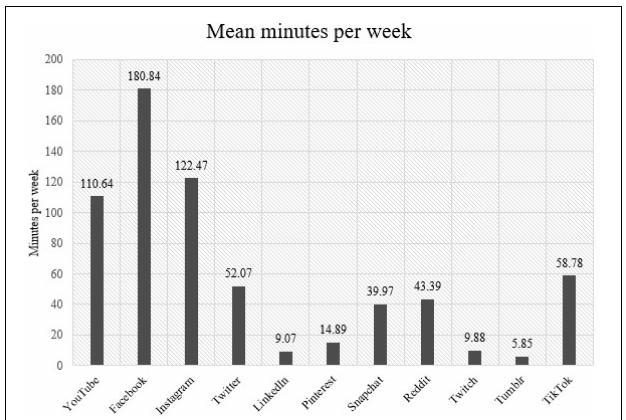
FIGURE 1 | Time spent using each platform per